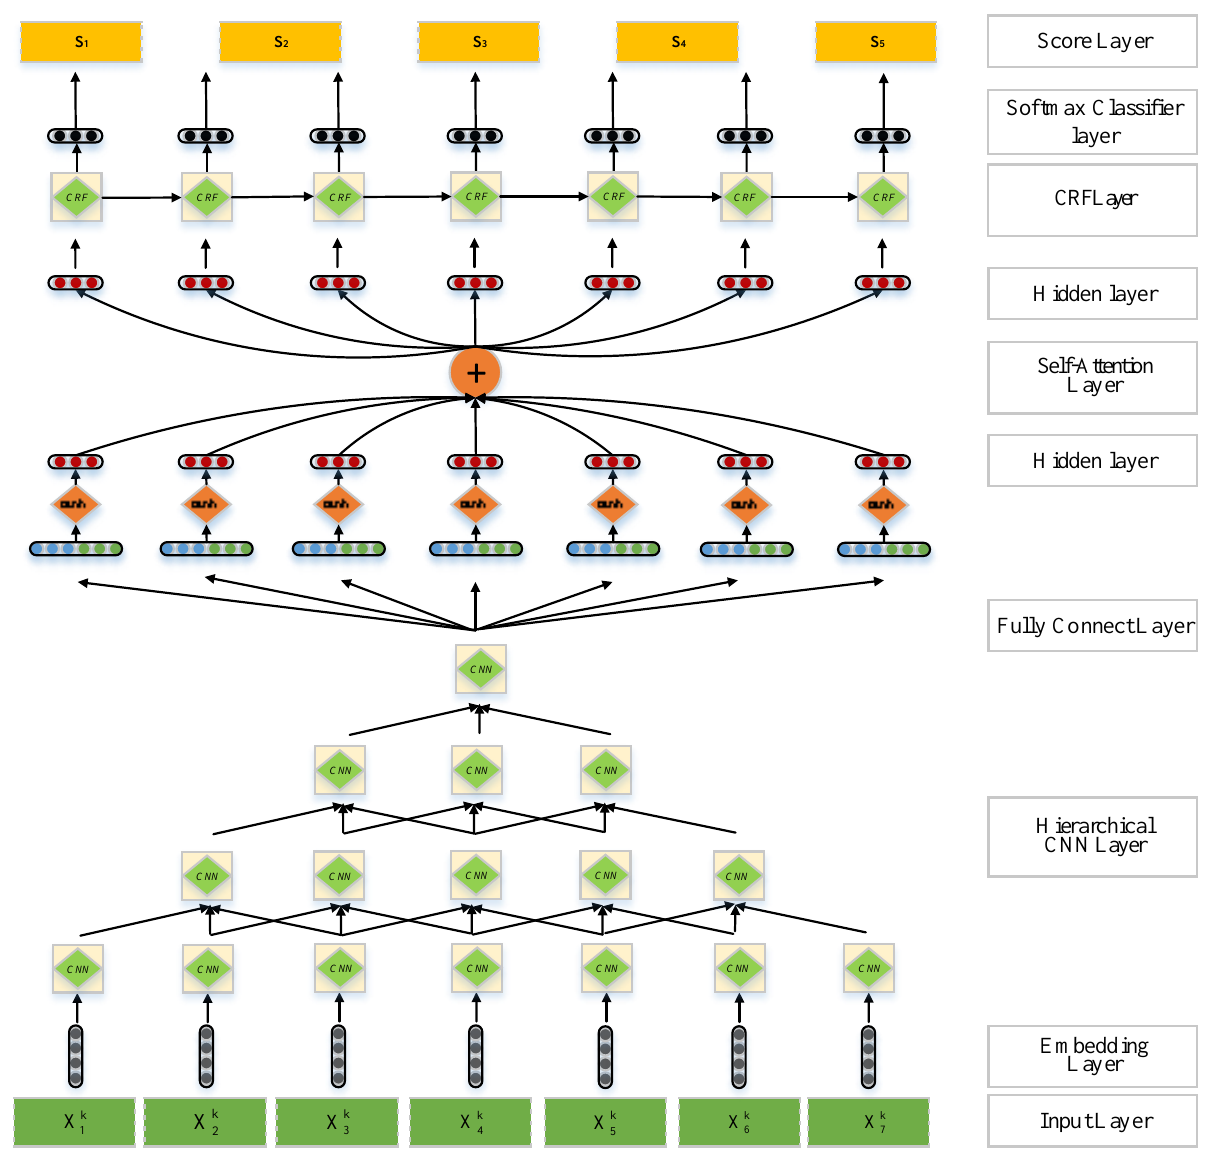
Figure 2. Investment risk assessment model